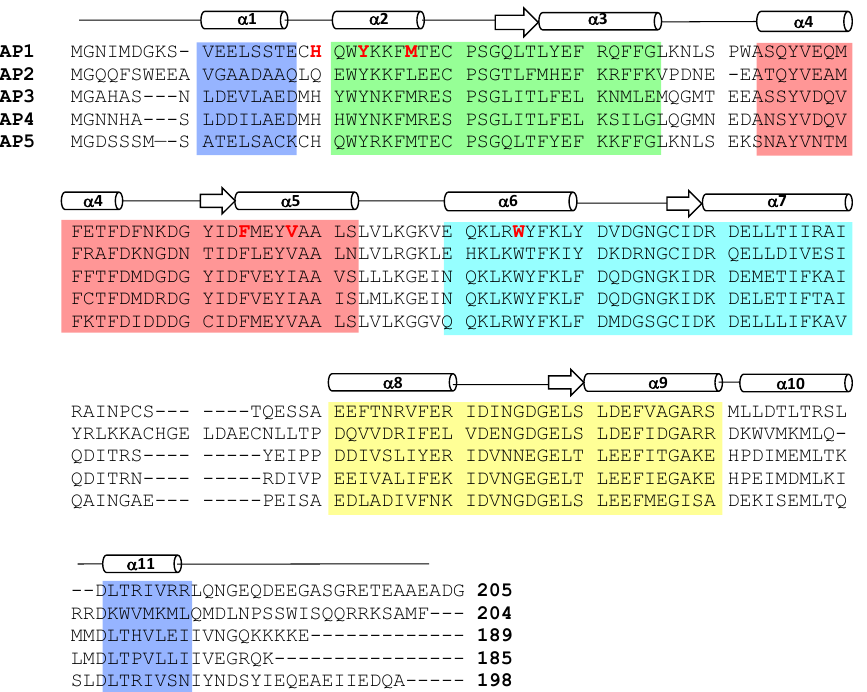
Figure 1. Amino acid sequence alignment of GCAP proteins (bovine GCAP1-2 and zebrafish GCAP3-5). Secondary structure elements (helices and strands) are depicted by cylinders and arrows. EF-hand residues are shaded in green, red, cyan, and yellow. The terminal residues that contact the myristoyl group are shaded purple. Exposed hydrophobic residues at the GCAP1 dimerization site are highlighted in bold and red.